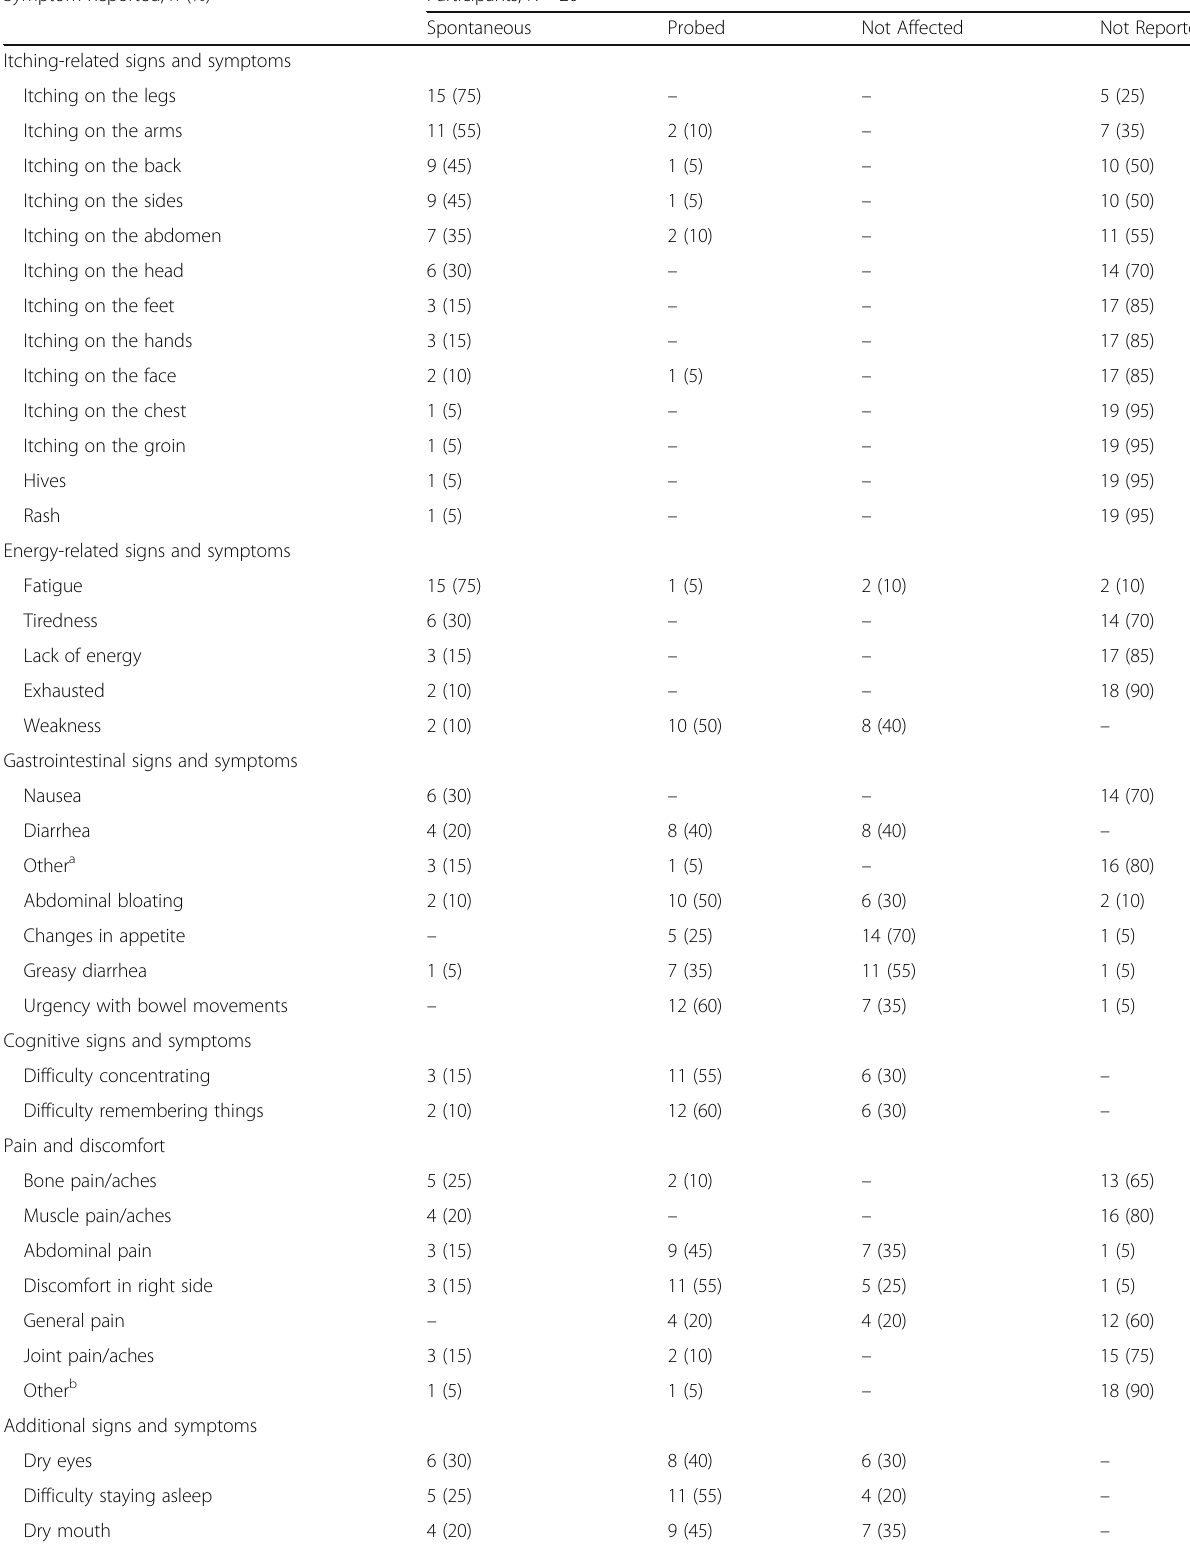
Table 3 Spontaneous vs probed symptom expressions during the CE portion of the interviews Symptom Reported, n (%) Participants, N = 20 Spontaneous Probed Not Affected Not Reported Itching-related signs and